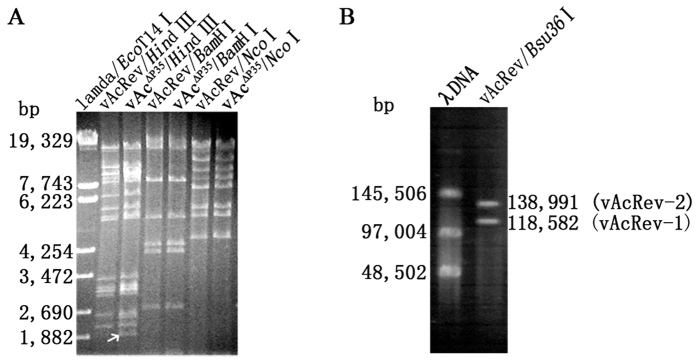
Restriction enzyme analysis of vAcRev genomic DNA.(A) Extracted DNA of vAcRev and vAc∆P35 were digested with HindIII, BamHI or NcoI, and the digested fragments were separated on 0.7% agarose gel. EcoT14I-digested λDNA was used as molecular size standards. (B) vAcRev genomic DNA was digested with Bsu36I and was analyzed by using pulsed field gel electrophoresis. λDNA was used as a marker.